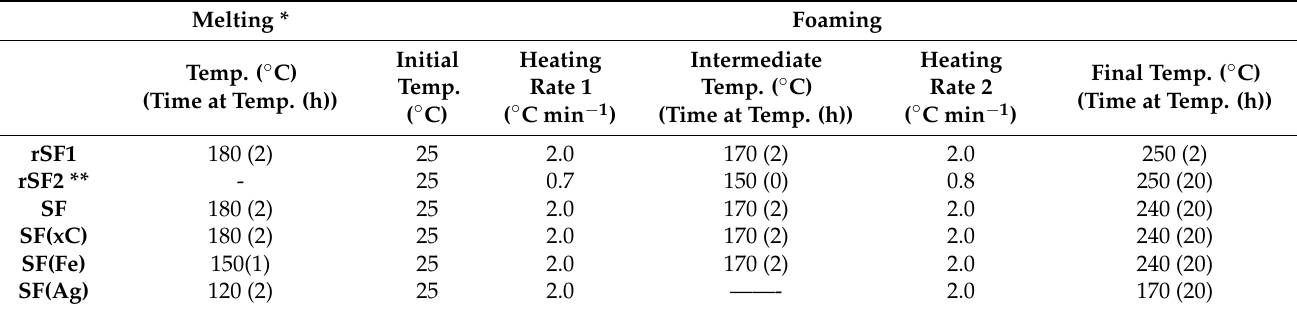
Table 1. Temperature programs used to obtain the sucrose foams